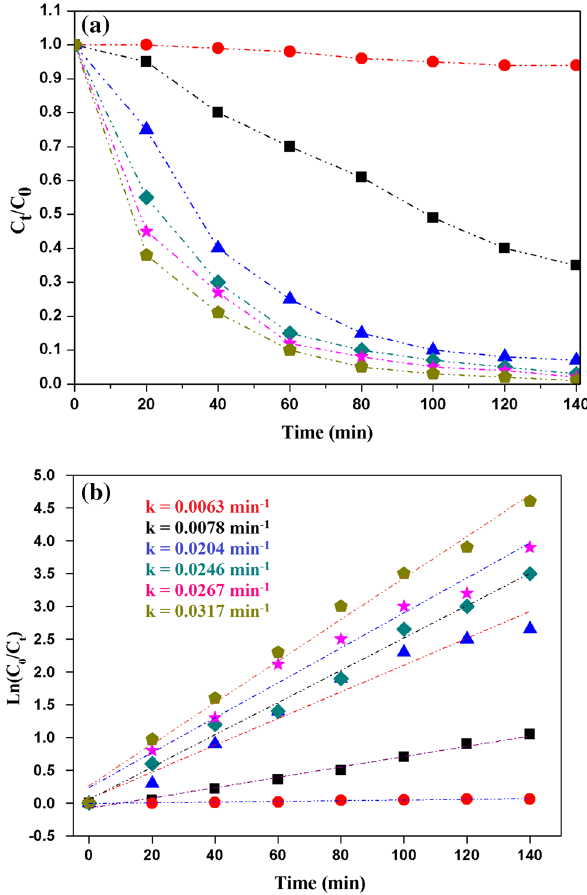
Fig. 5 Effects of scavengers on the photodegradation of 4-NP by ZrO 2 /g-C 3 N 4 (red color circle: BQ, block color square: KI, pink color star: IPA, light green color diamond: NaF, blue color triangle: KBrO 3 , dark green color pentagon: no scavenger)